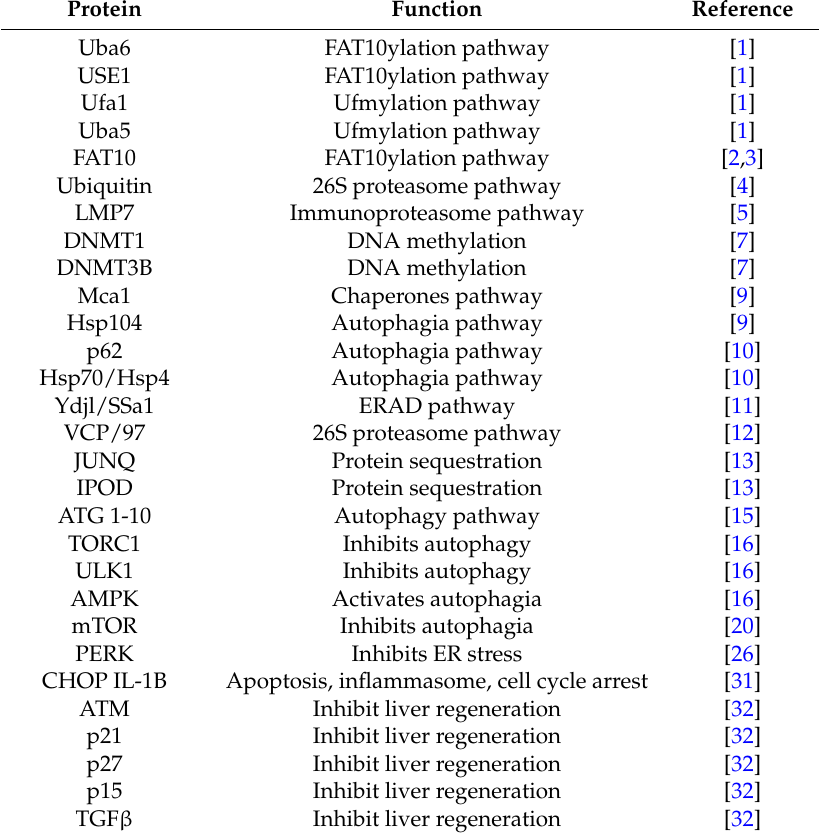
Table 1. Proteins changed which contribute to loss of protein quality control in